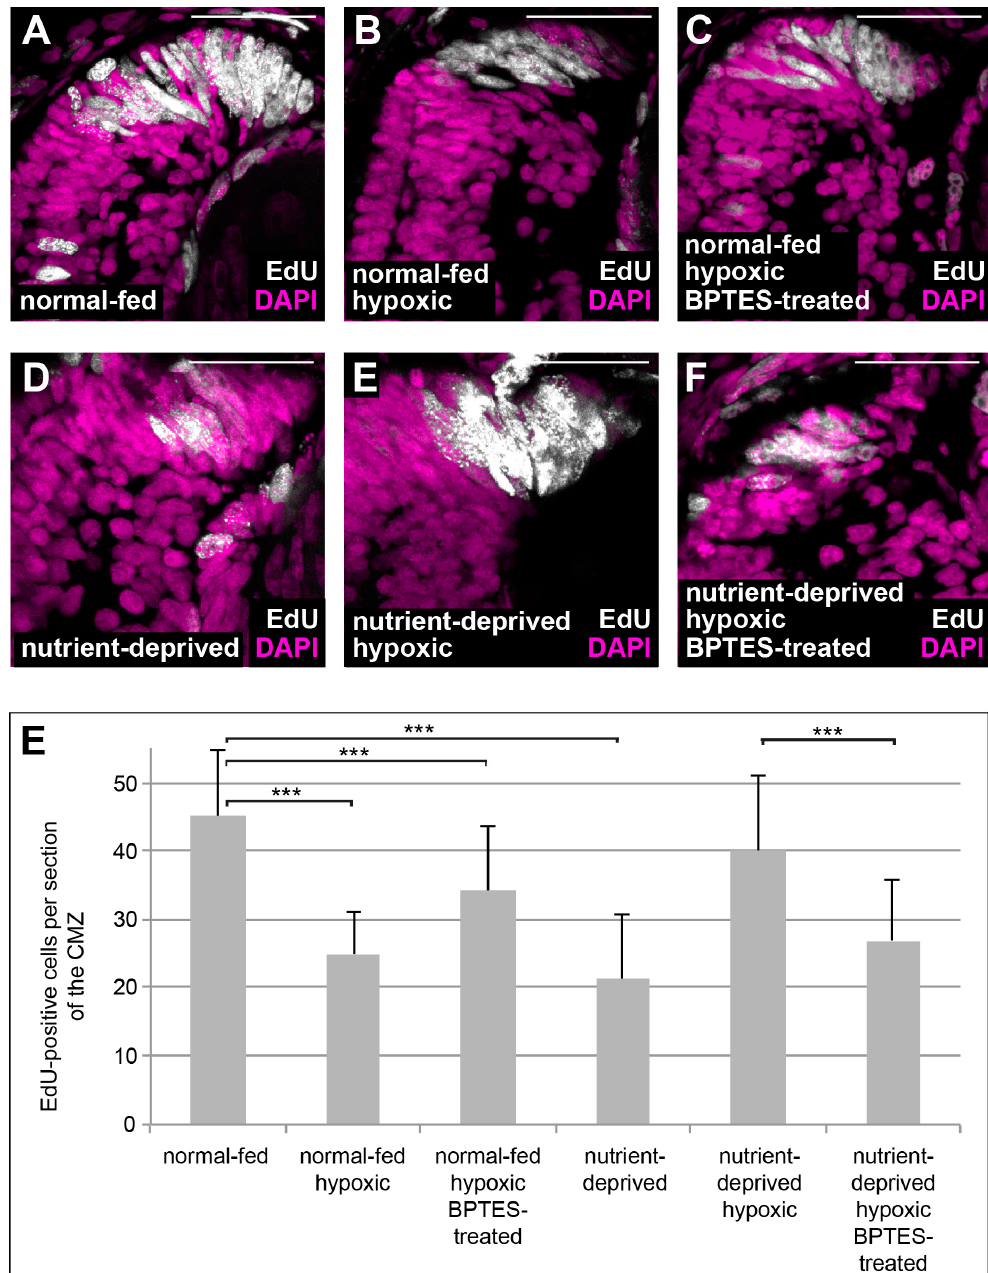
Figure 4. Block in glutaminolysis interferes with re-initiation of proliferation in nutrient-deprived hypoxic retinas. ( A – F ) EdU incorporation in DAPI-stained retinas from normal-fed animals ( A – C ) kept in normoxia ( A ), hypoxia ( B ) or incubated with BPTES under hypoxia ( C ) and in nutrient-deprived animals kept in normoxia ( D ), hypoxia ( E ) or incubated with BPTES under hypoxia ( F ). Nutrient-deprived retinas no longer resume their proliferation in hypoxia when glutaminolysis is blocked by BPTES. Scale bars = 50 µm. In each condition, a minimum of 8 retinas was observed. ( E ) Quantification of the experiment performed in ( A – F ). Error bars represent standard deviations between three independent experiments. Two hooked ends of horizontal lines indicate the two conditions compared, *** p -value < 0.001, n = 3. For each condition, between 8 and 17 retinas were quantified.